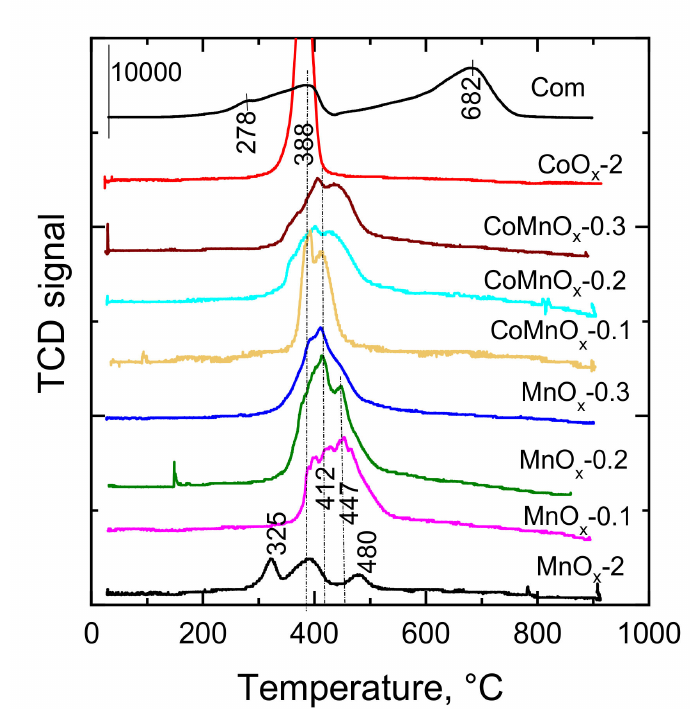
Figure 4. TPR profiles of the examined